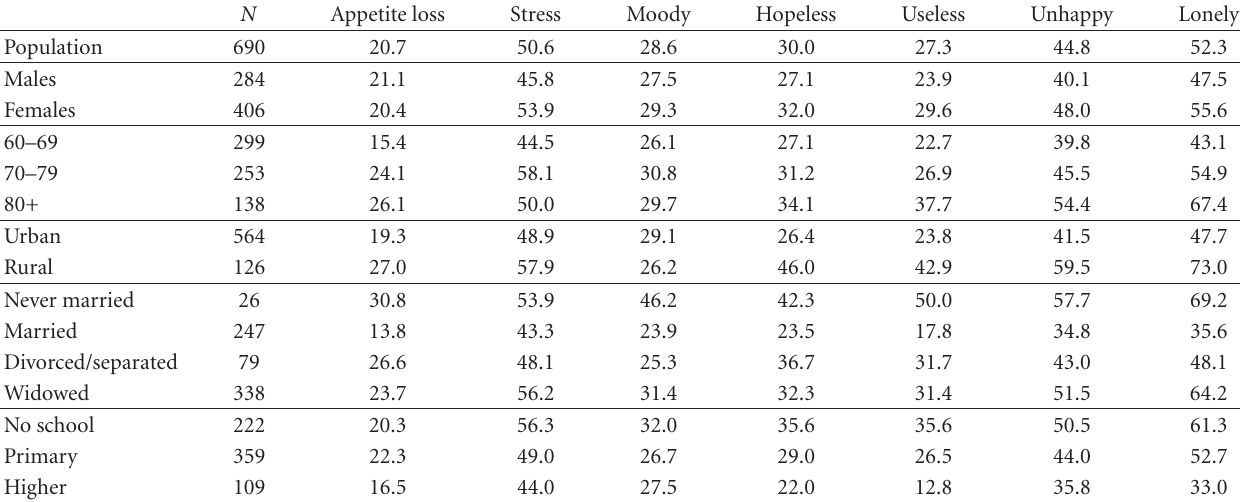
Table 2: Percent reporting indicators of social isolation by sex, age, residence, marital status, and education.